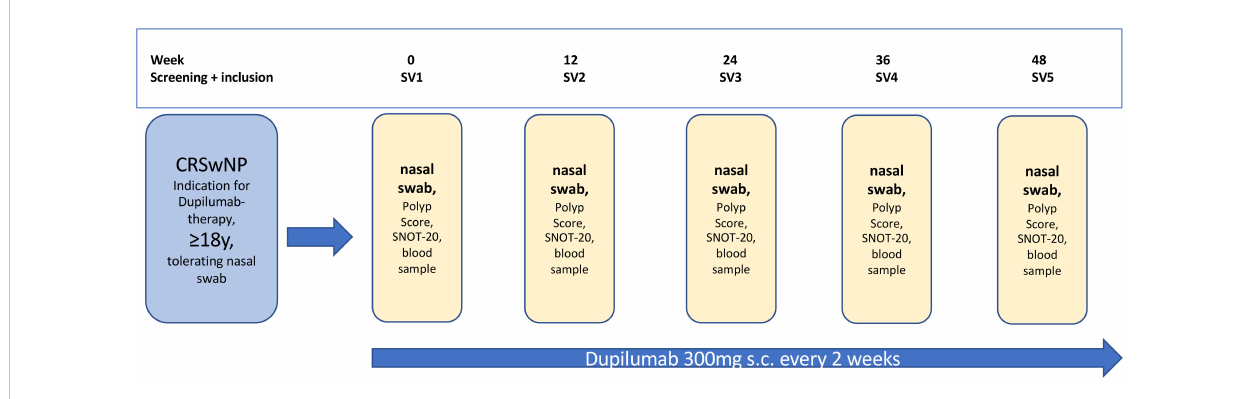
FIGURE 1 Study fl ow chart, SV, study visit; SNOT-20, 20-item sino-nasal outcome test; y, years; s.c.,